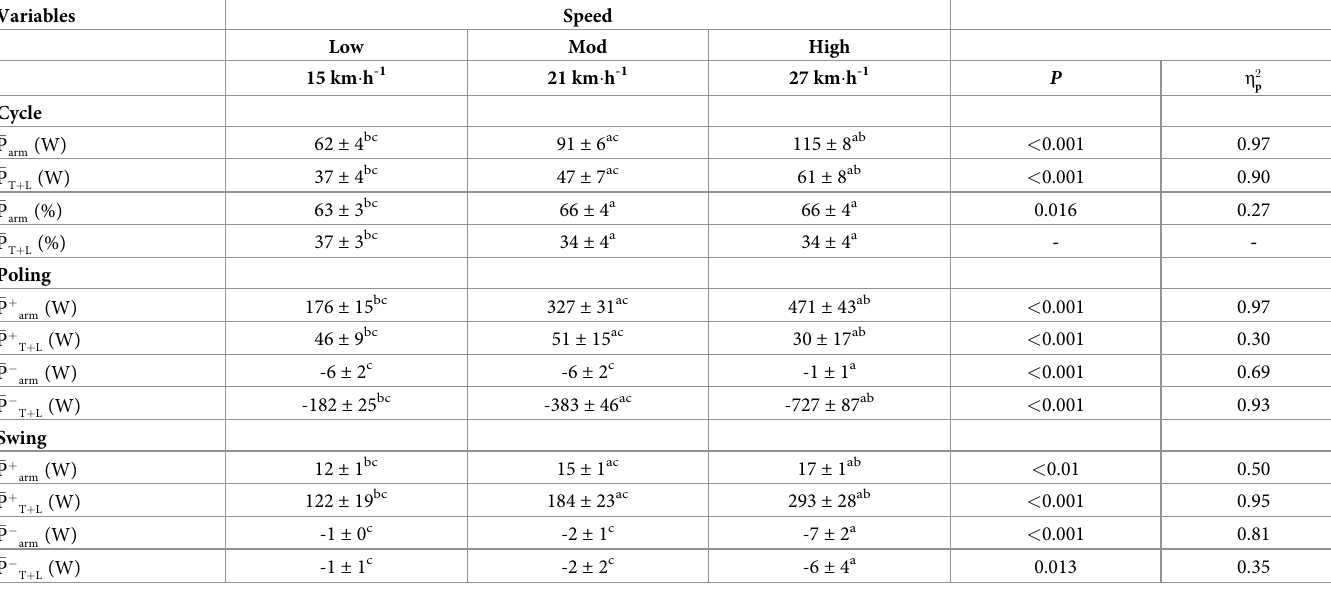
Values are mean ± 95% CI, P -values and η 2 for the repeated measures ANOVA [N = 14]. a, b, and c indicate significant differences from low, moderate, and high speeds, p respectively ( P <